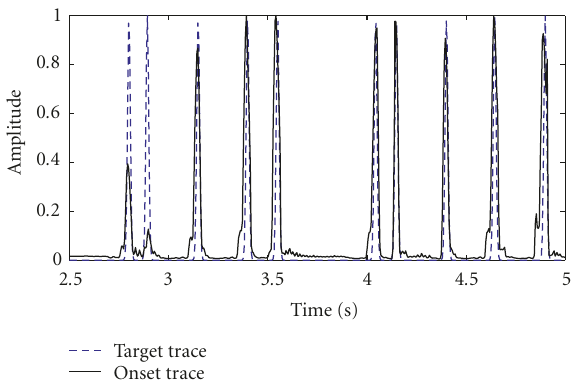
Figure 10: The target trace represents the ideal curve for the peak- picking part of the algorithm. The onset trace shows the merged output of the neural